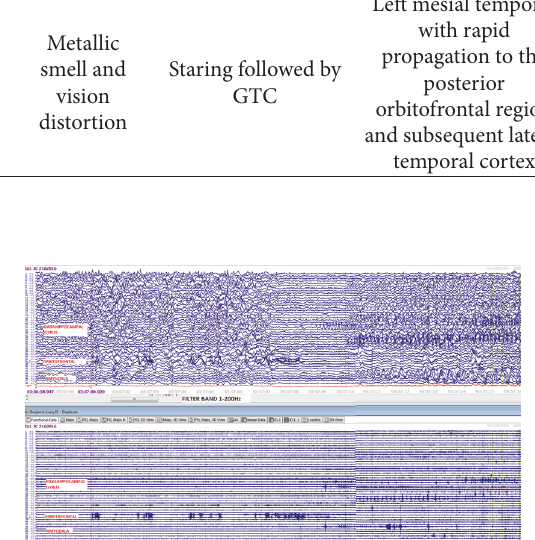
Figure 1: This synchronized ictal EEG on patient three at the onset of a typical seizure. The top EEG depicts interictal HFO evolving to ictal pattern. The bottom EEG only shows focal slowing at the onset but the ictal HFO is obscured by the filter.